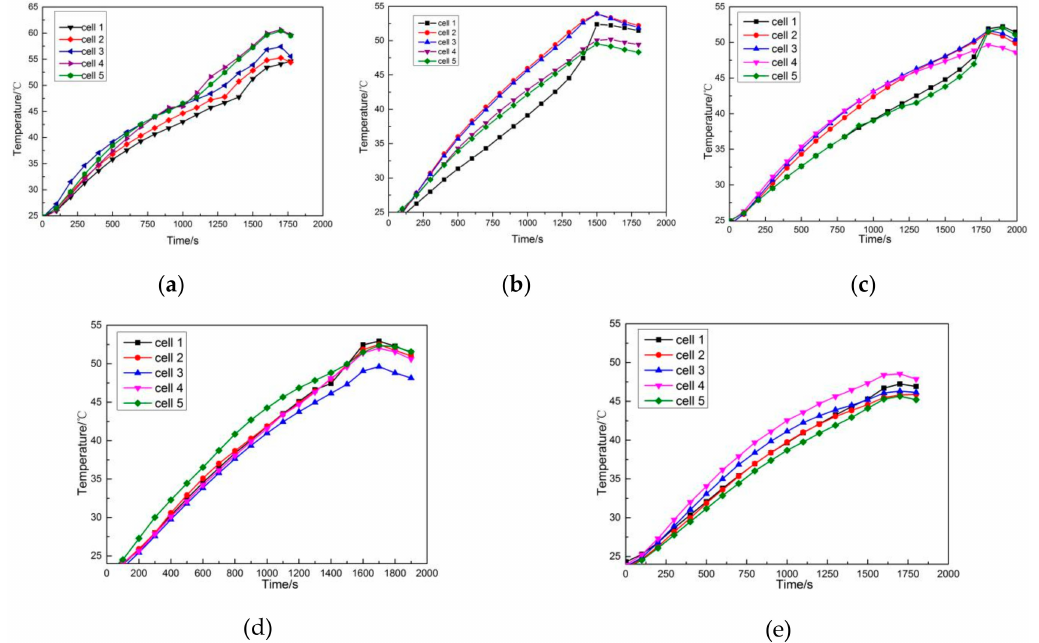
Figure 8. Surface temperature curve of the battery under di ff erent graphite content of 2C discharge rate: ( a ) 0% EG; ( b ) 5% EG; ( c ) 10% EG; ( d ) 15% EG; ( e ) 20%